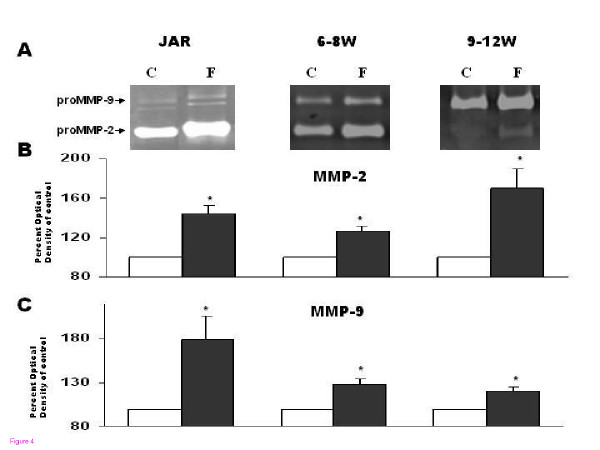
Secretion of proMMP-2 and proMMP-9 after 48 hours incubation of JAR cells, 1st trimester trophoblast cells 6–8 week or 1st trimester trophoblast cells 9–12 week in medium in absence or presence of 10 μM Forskolin. (A) Representative zymography gels. (B) Bar graph, representing mean ± SEM from 10 independent experiments detecting proMMP-2 (72 kD). (C) Bar graph, representing mean ± SEM from 10 independent experiments detecting proMMP-9 (92 kD). White bars represent control medium of cells without treatment. Black bars represent medium from cells with forskolin treatment. *P < 0.05 vs. control.